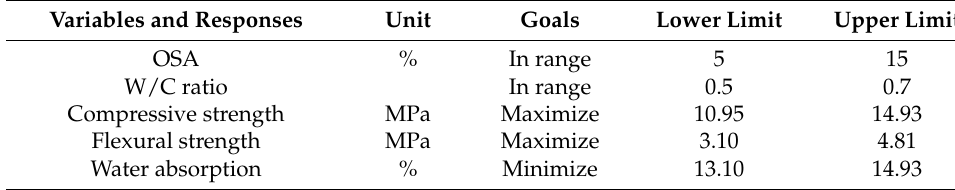
Table 8. Optimization benchmarks.